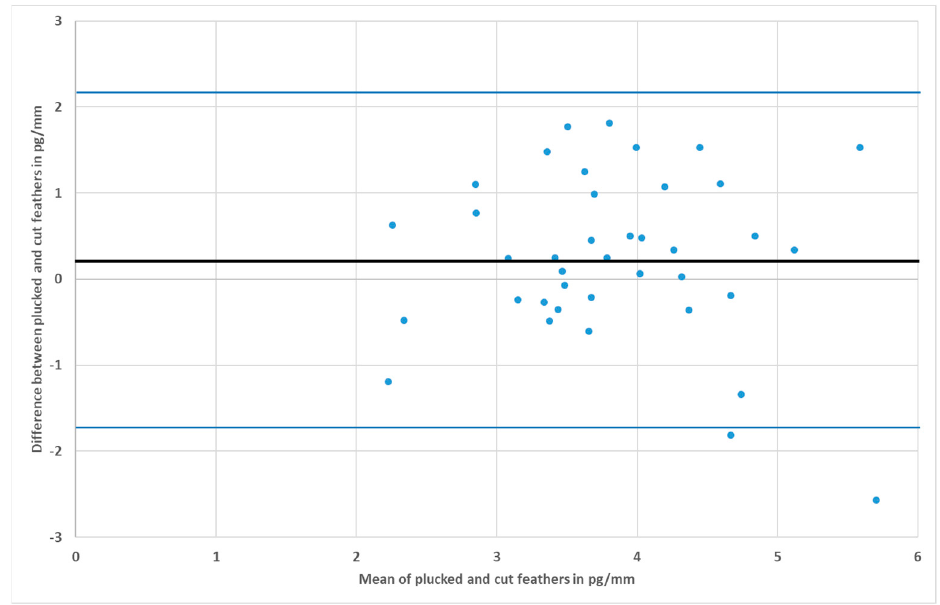
Figure 5. Bland–Altman plot of Anser without the outlier; the residual plot displays the differences (y-axis) against the means of values (x-axis). The blue horizontal lines represent the mean difference ± 2 SD (mean = 0.25, SD = 0.97).